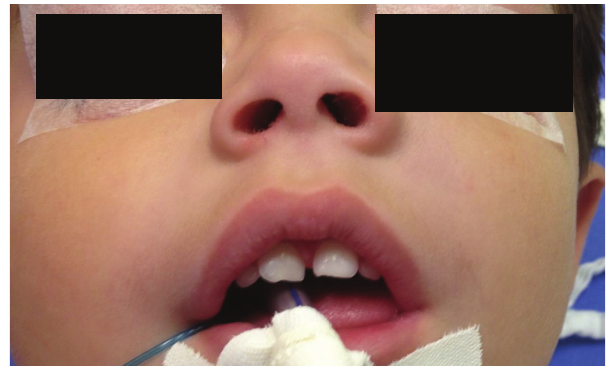
Figure 1: Face asymmetry before surgery.